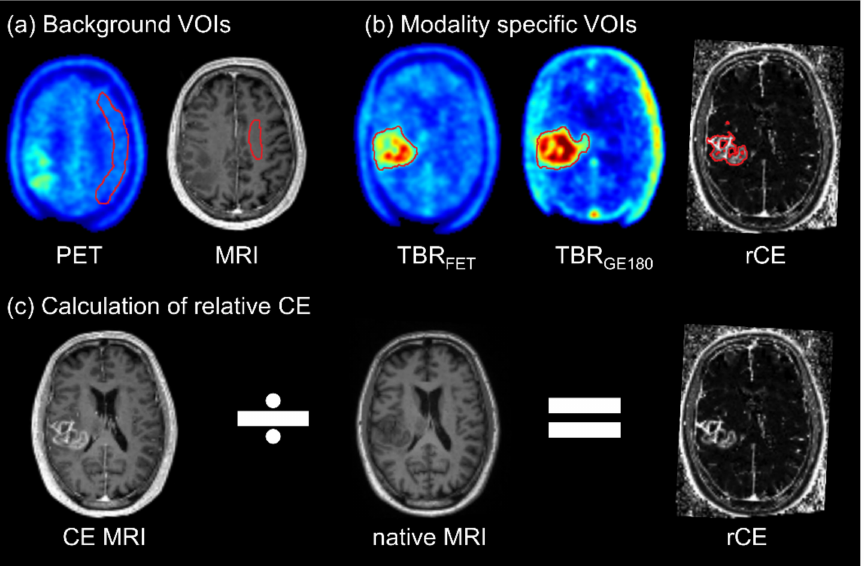
Figure 1. Segmentation and normalization methodology. ( a ) Background VOIs were delineated on the contralesional side. Crescent shaped background volume containing grey and white matter for normalization of static PET images and background VOI in white matter for normalization of T1- and T2-weighted MRI images. ( b ) Exemplary modality specific delineated volumes segmented in tumor- to-background (TBR FET , TBR GE180 ), and relative contrast enhancement (rCE) images. ( c )